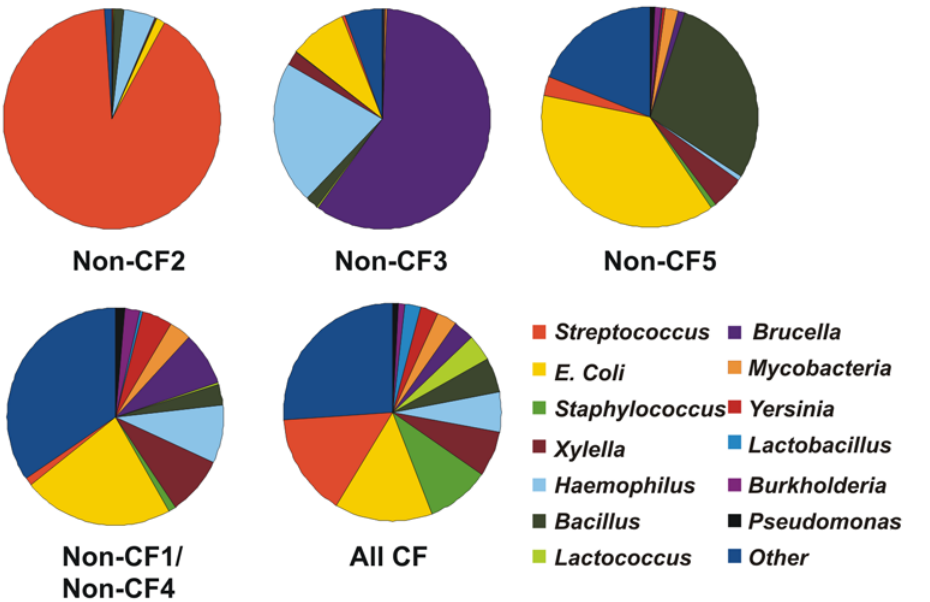
Figure 3. Putative host range for phage communities in respiratory tract viromes. Host range was inferred from normalized best tBLASTx hits to phage genomes. Host ranges for CF viromes and for Non-CF1Asthma and Non-CF4Spouse were not statistically significantly different as determined by XIPE and were combined.